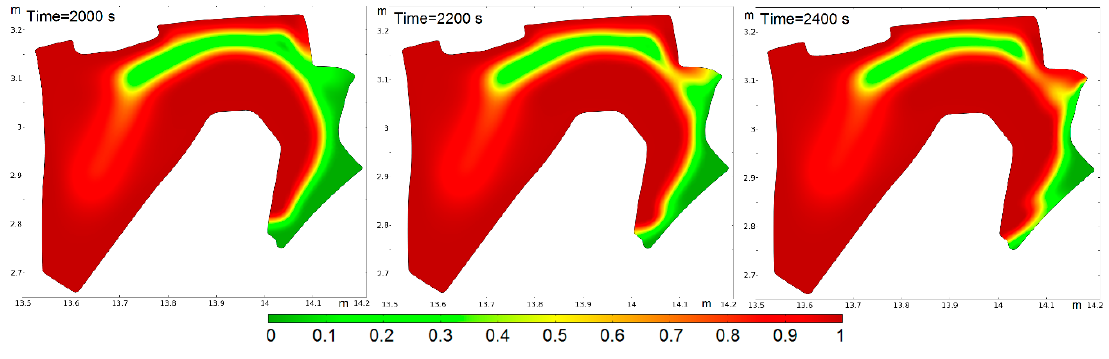
Figure 15. Closing an unfilled region of the preform by the inner resin flow front. Three snapshots show a sequential change of the resin volume fraction distribution in the preform.